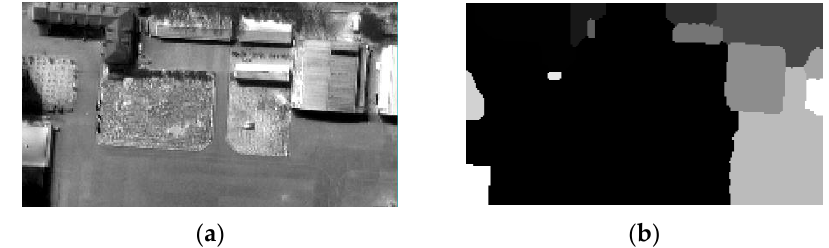
Figure 13. Car data set. ( a ) Radiance domain image and ( b ) segmentation map.